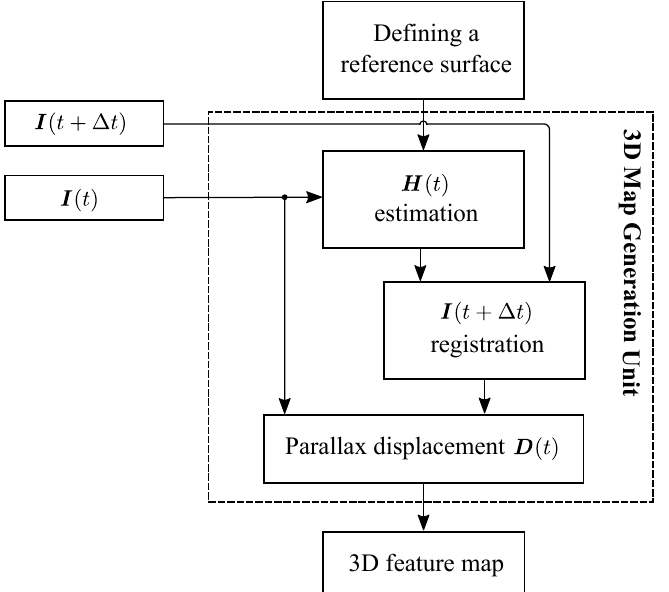
Figure 1. The 3D feature map of a scene using a pair of aerial